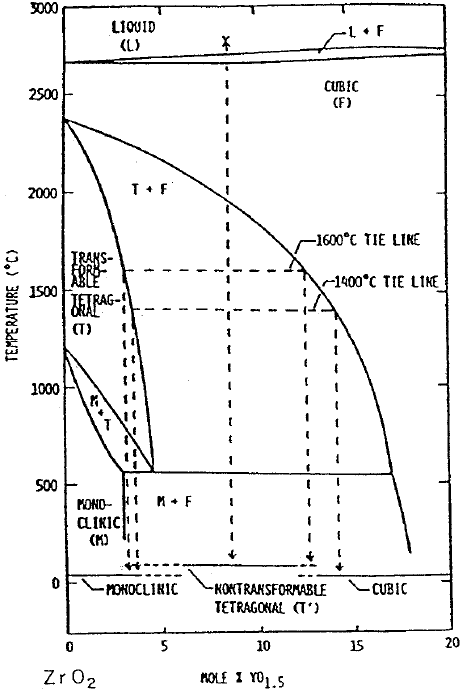
Figure 12. Phase diagram of the system ZrO 2 -Y 2 O 3 .